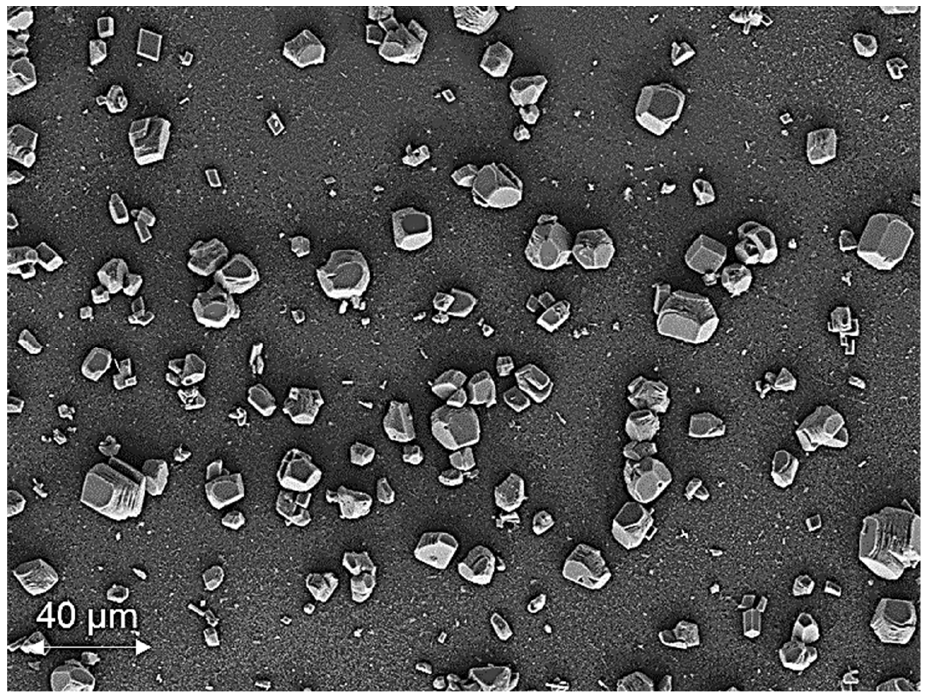
Figure A3. SEM top-view image of SNS-PA membrane after 24 h calcium carbonate scaling test (crystal surface coverage ~25%).